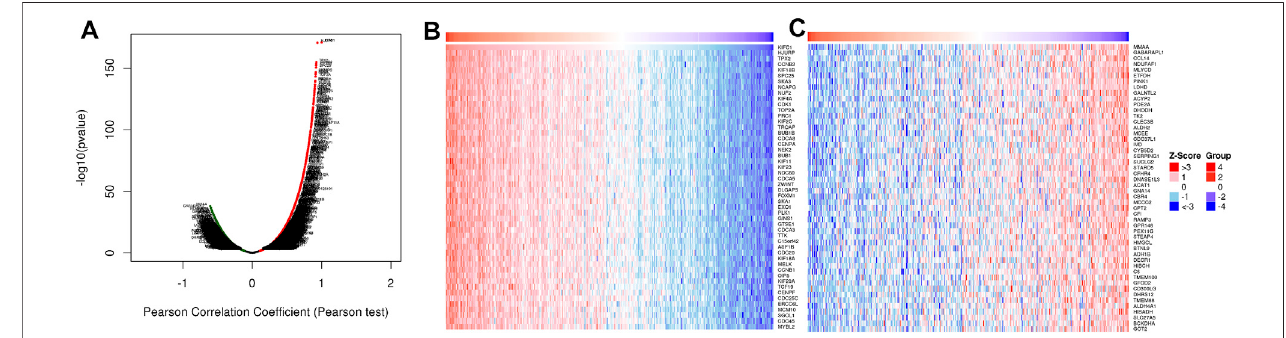
FIGURE 7 | Genes differentially expressed in association with KIFC1 in LIHC. (A) Volcano plot. (B, C) Heat maps of the top 50 genes positively and negatively correlated with KIFC1.